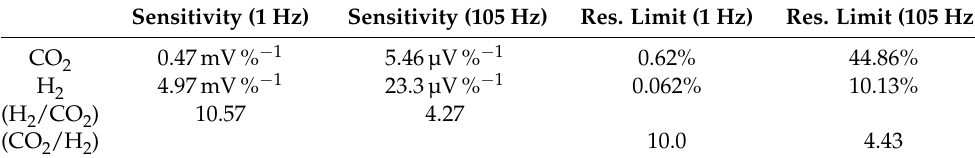
Table 2. Overview of the sensitivities as well as resolution limits at 1Hz and 105Hz, respectively, for both CO 2 and H 2 measurements. The ratios of both quantities become smaller as the frequency increases. Note that the ratio was inverted in case of the resolution limit in order to find ratios greater than